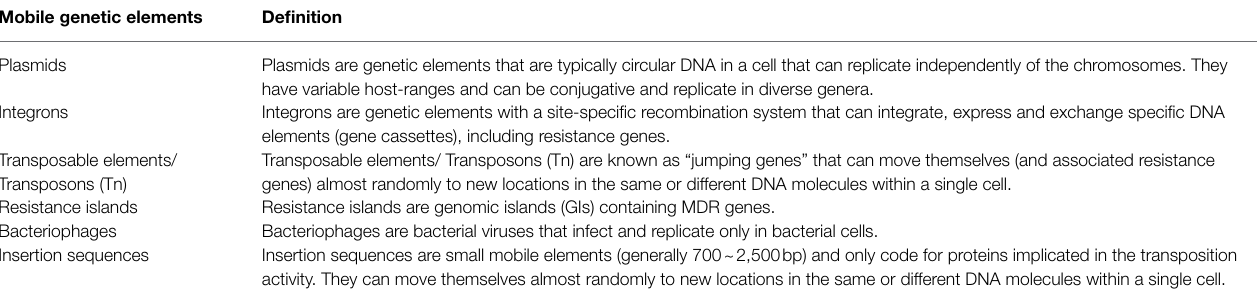
TABLE 4 | Summary of terms and definitions of mobile genetics elements (MGEs) in Salmonella enterica . Mobile genetic